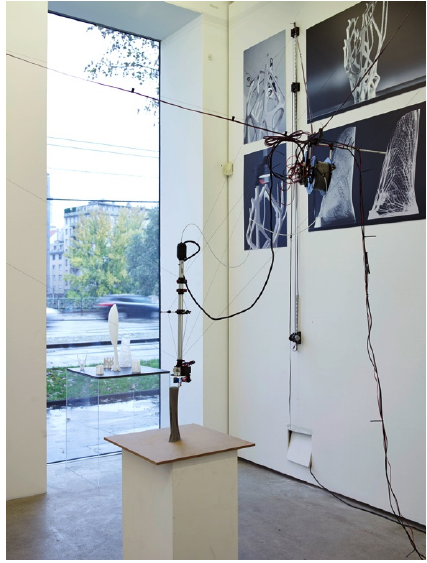
Figure 18. Parallel cable printer installed in the exhibition space. © Bruno Stubenrauch.